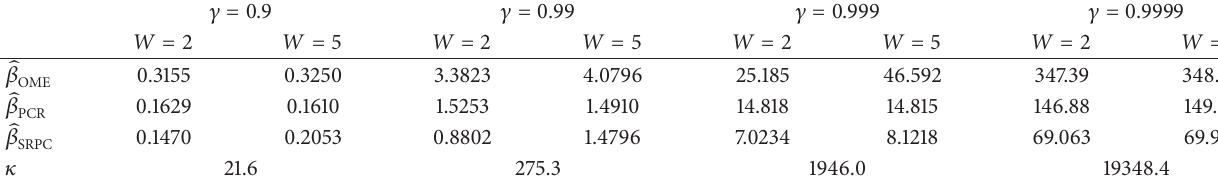
Table 3: Estimated MSE with 𝑛 = 50